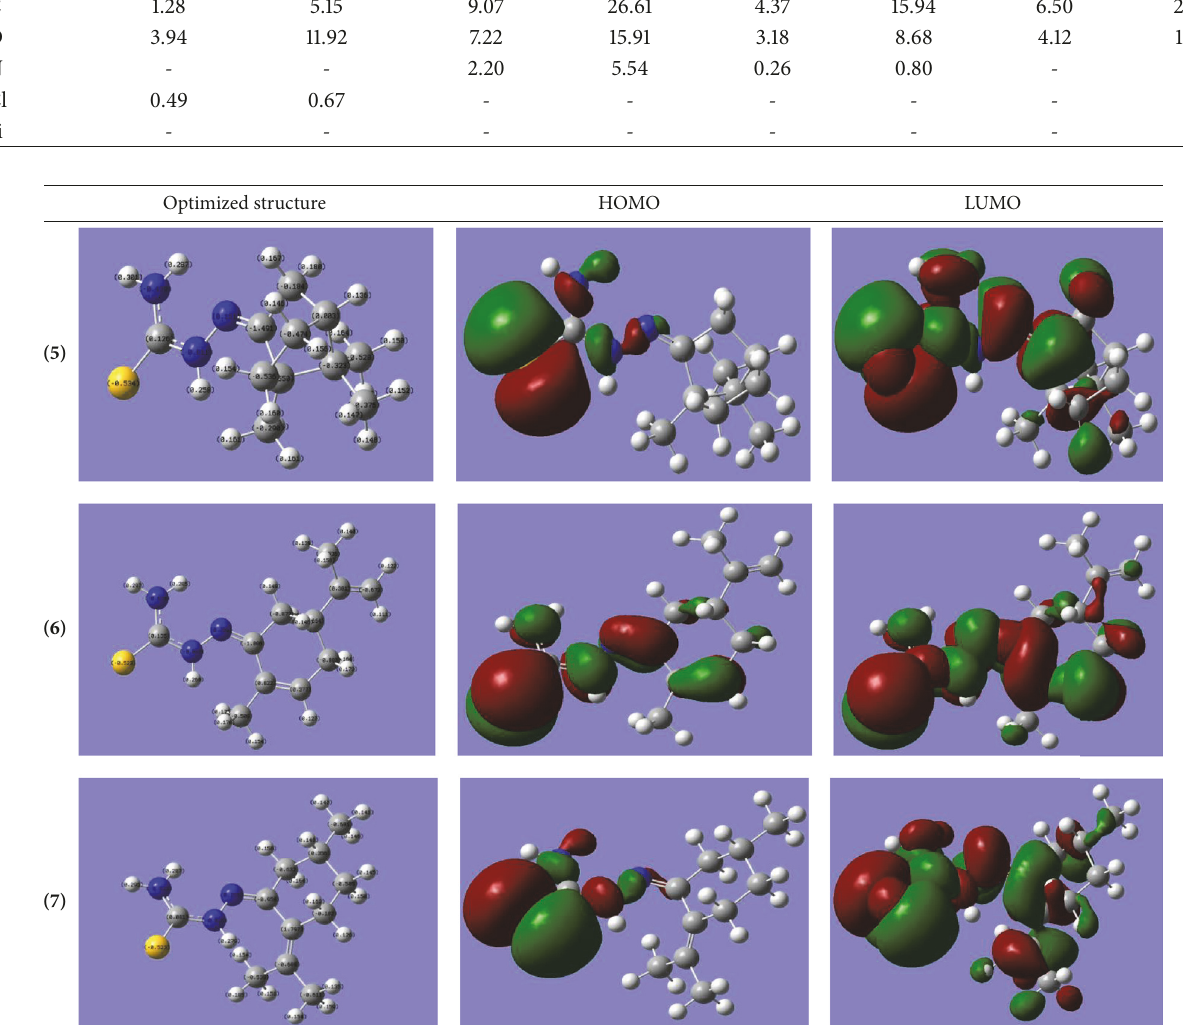
Figure 10: Calculated energies of HOMO and LUMO molecular orbitals and optimized structure of the studied molecules using B3LYP/6- 311G (d,